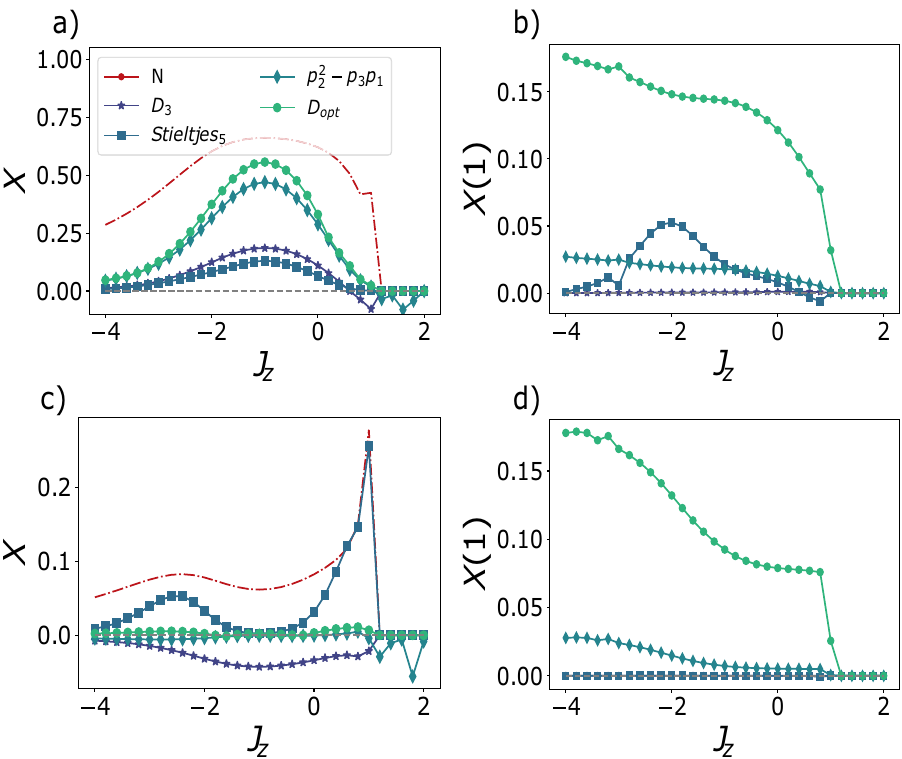
; Stieltjes ; p 2 (cid:5) p 3 p 1 ; N (cid:7) we denote the conditions 5 3 2